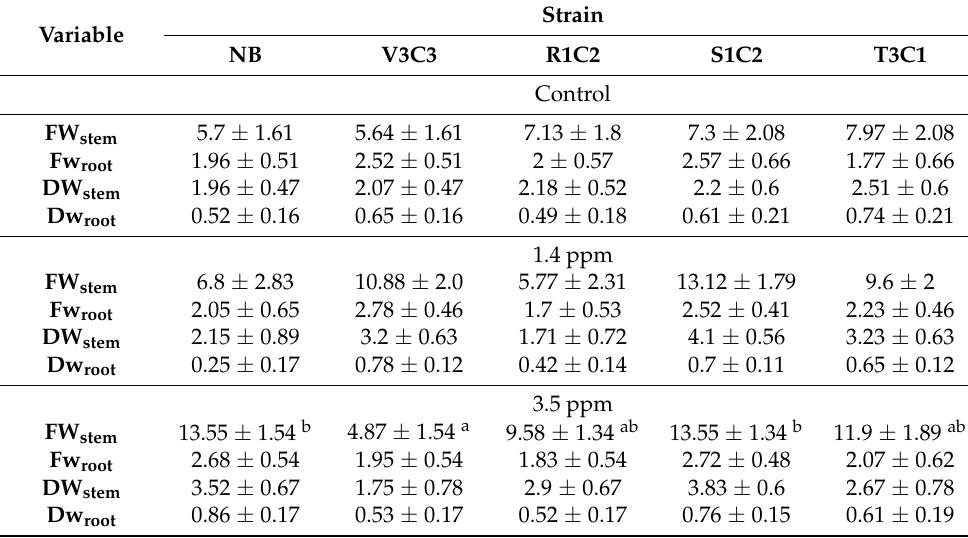
Table 2. Plant growth variables of Theobroma cacao inoculated with Pseudomonas and Bacillus strains under soil supplemented with